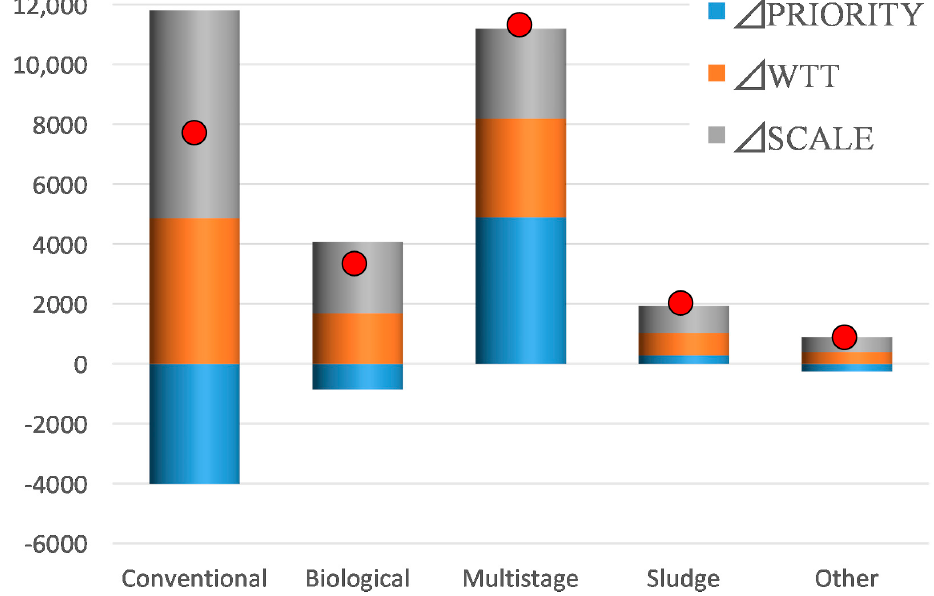
Figure 2. Results of the patent decomposition analysis (number of patents). Note: The vertical axis is standardized by setting the number of changes in the patents granted in 1993 to zero. The sum of the bars is equivalent to the value of the plotted point.